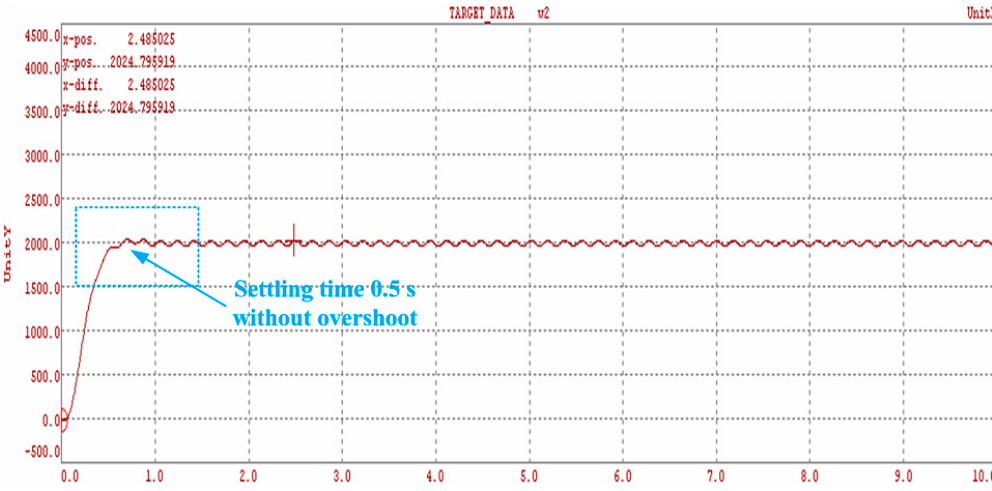
Figure 10. Experimental test effect of the designed fuzzy PID controller on the torsional vibration control of the flexible-joint robot system.